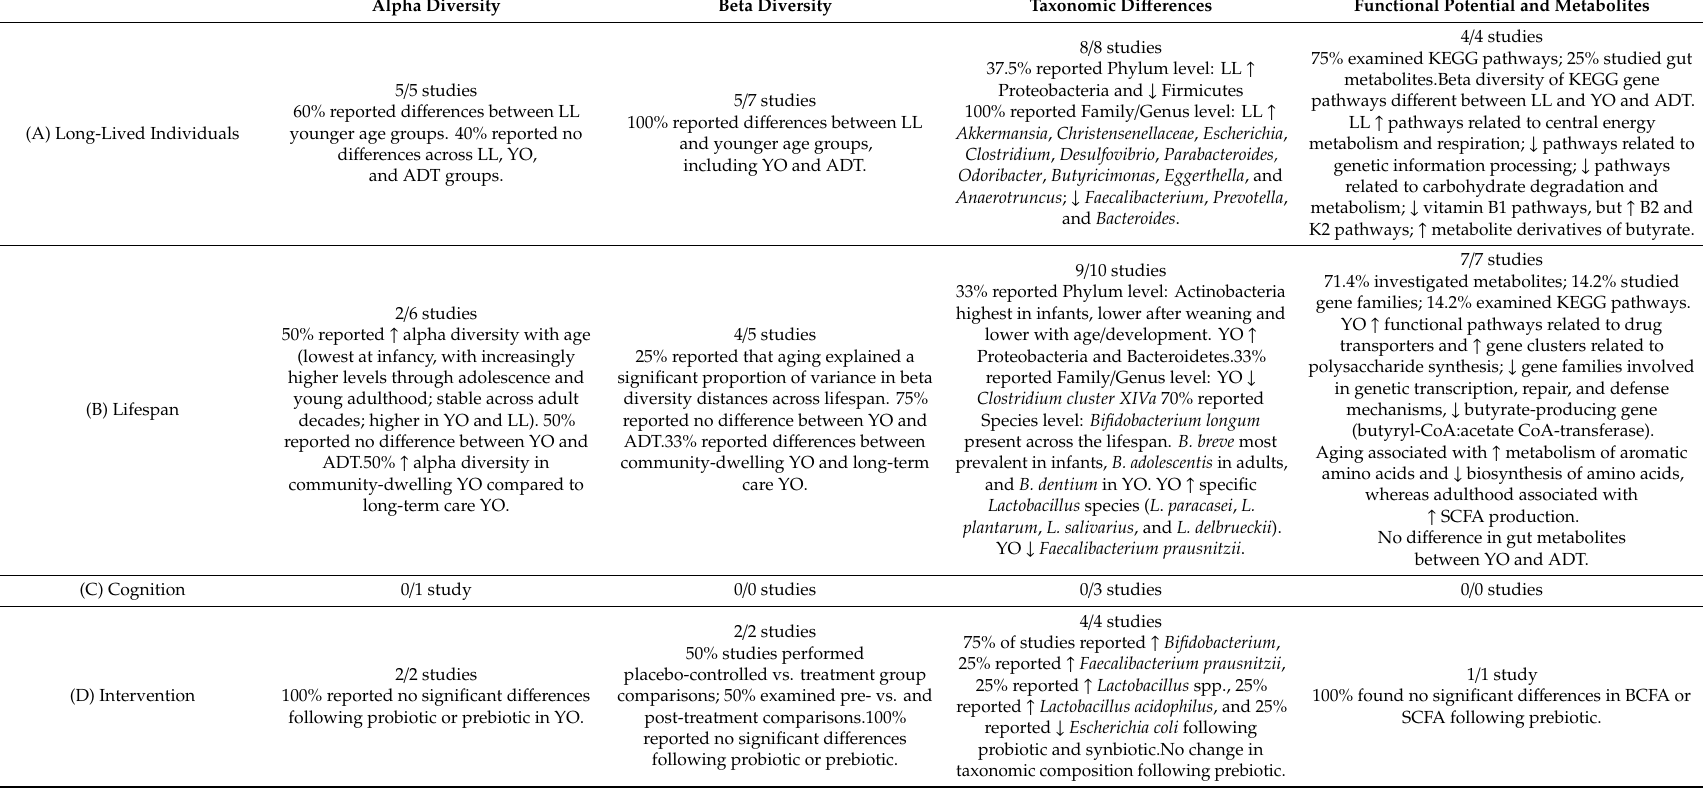
Table 2. Summary of age-related findings for each gut microbiota metric across di ff erent categories of